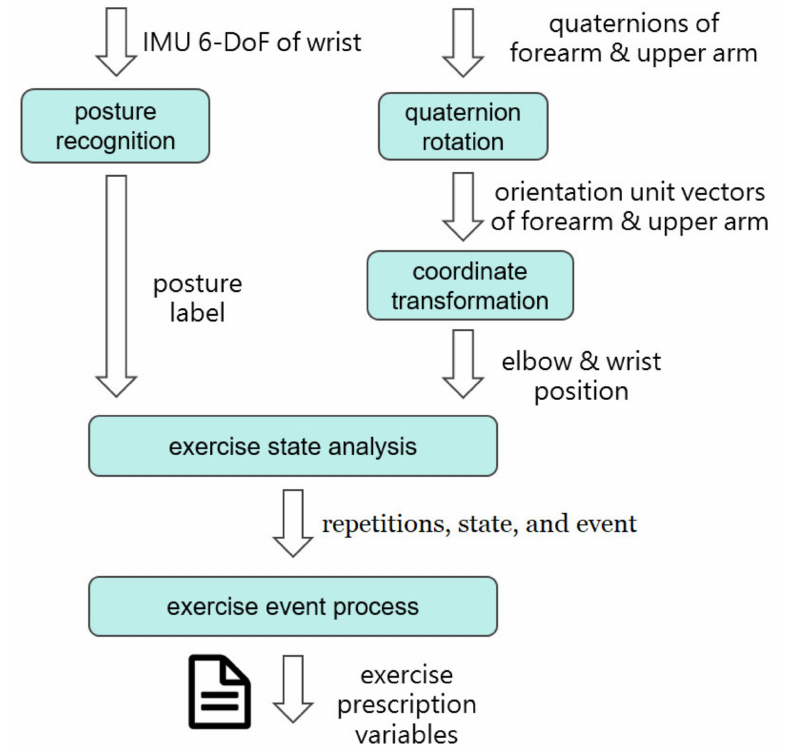
Figure 2. Flowchart of the presented